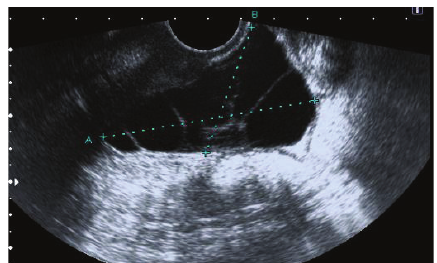
Figure 1: Ultrasound scan image of pelvic multicystic mass.